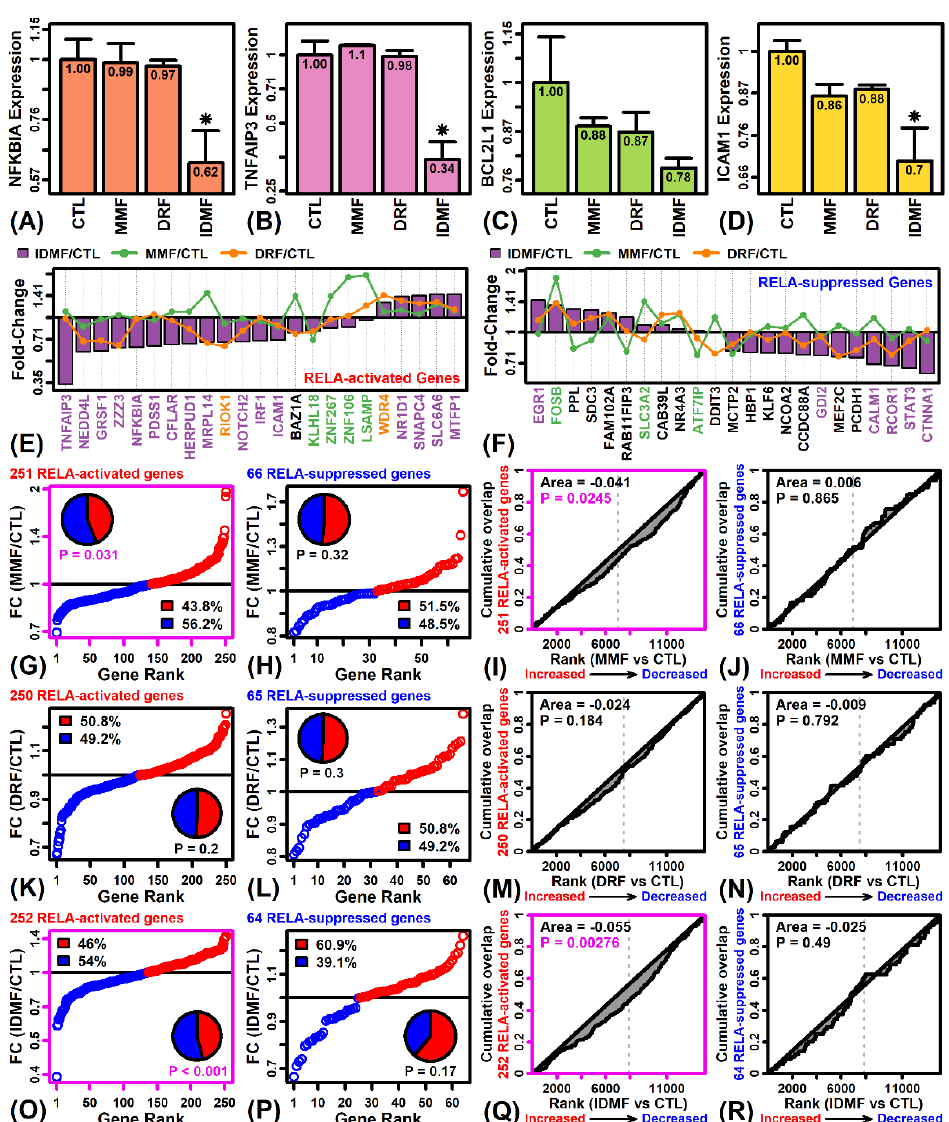
Figure 5. NF-kB (RELA) target genes. ( A ) NFKBIA . ( B ) TNFAIP3 . ( C ) BCL2L1 . ( D ) ICAM1 . In ( A – D ), average expression (log 2 scale) is shown for each treatment (±1 standard error; * p < 0.05, comparison to CTL treatment). Expression is normalized to the average value in the CTL treatment for each gene. ( E ) RELA-activated genes. ( F ) RELA-suppressed genes. In ( E , F ), the value of |FC| max was calculated for each gene, where |FC| max is defined as max[abs(FC MMF , FC DRF , FC IDMF )], and the 23 RELA-activated or RELA-suppressed genes with highest value of |FC| max are shown. Non-black gene labels are used if there is significant differential expression ( p < 0.05) for any of the three comparisons, in which case the label color matches the comparison associated with the lowest differential expression p -value. ( G , H , K , L , O , P ) FC estimates for RELA-activated genes. FC estimates are plotted and the proportion of fumarate-increased (red) fumarate-decreased (blue) genes is shown ( p -value: Fisher’s exact test). The percentage of increased/decreased genes is also indicated (see legend). ( I , J , M , N , Q , R ) The cumulate overlap is shown between RELA-activated genes and genes ranked based upon their response to each fumarate compound. A positive area statistic denotes enrichment among fumarate-increased genes, and a negative area statistic indicates enrichment among fumarate-decreased genes ( p -value: Wilcoxon rank sum